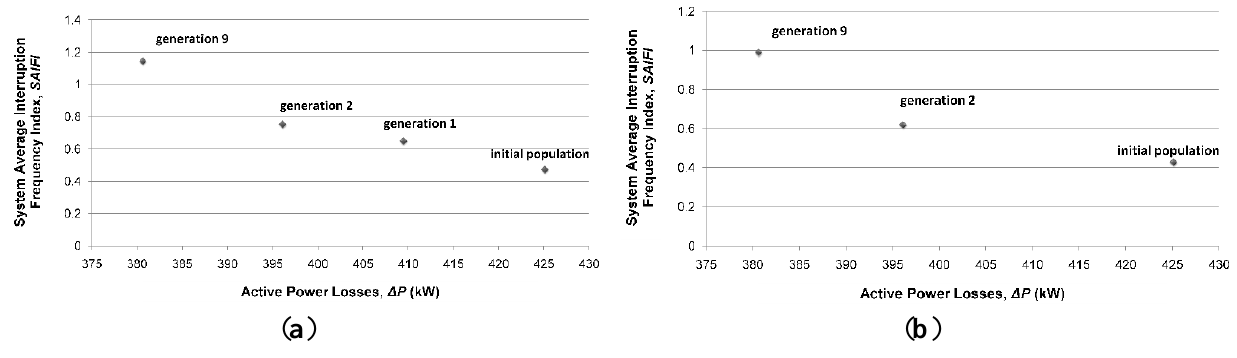
Figure 7. The Pareto front (in the case of minimum CPU runtime): ( a ) for system B with DG units; ( b ) for system B with